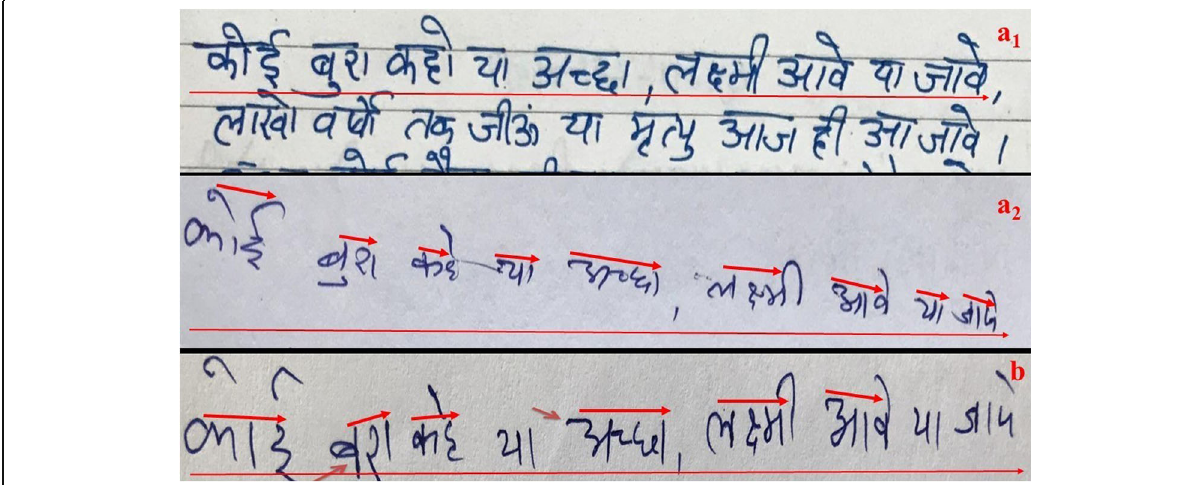
Fig. 8 Alignment. a 1 Handwriting before onset of RA showing mixed alignment. a 2 Change in overall alignment along downhill direction in handwriting of RA patient. b Mixed alignment in copied